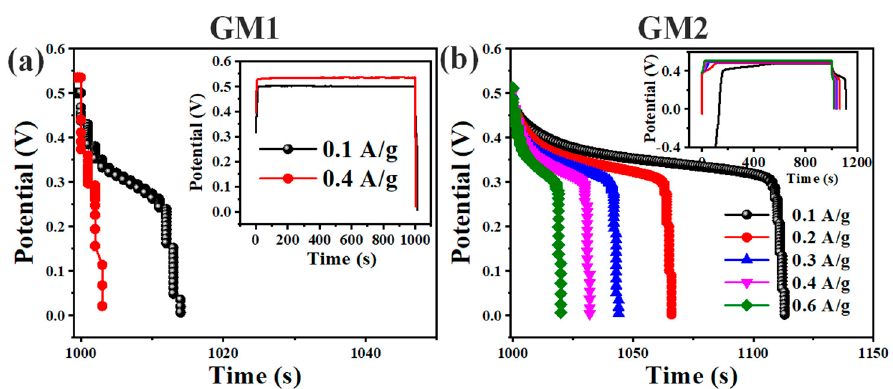
Figure 8. Galvanostatic charge–discharge curve of ( a ) GM1 and ( b ) GM2 at varying current density in given potential of 0.6 V.